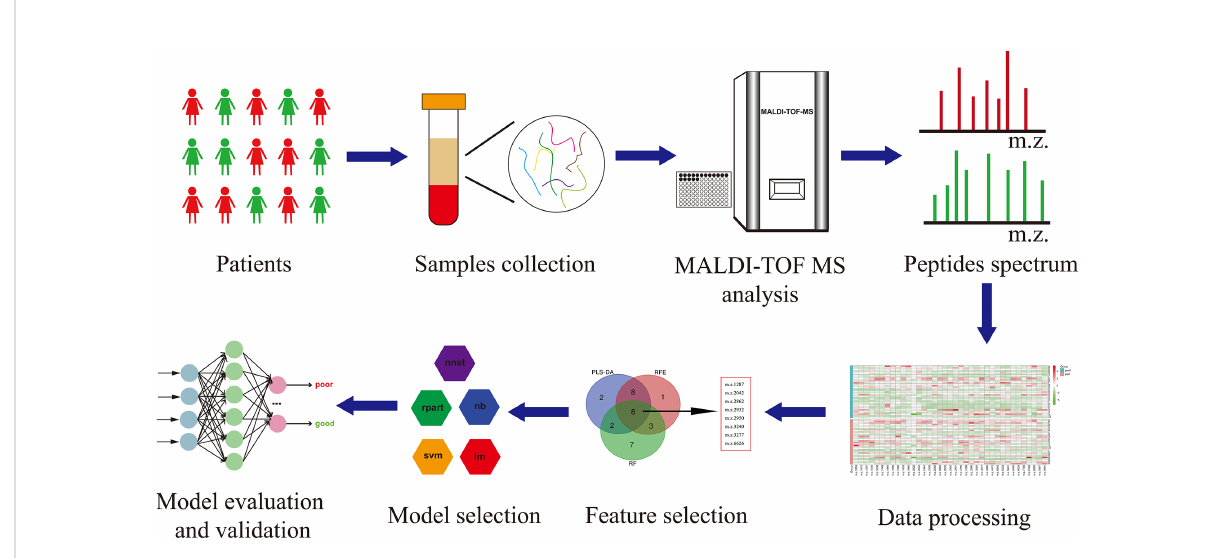
FIGURE 2 The work fl ow of serum peptide pro fi les analysis. Serum from patients containing various peptides/proteins was collected and subsequently processed for analysis using MALDI-TOF MS. The obtained peak patterns were normalized and then the machine learning algorithms were used to perform feature selection. The different machine learning methods were implemented and compared to eventually yield a robust model, which was further evaluated and validated.